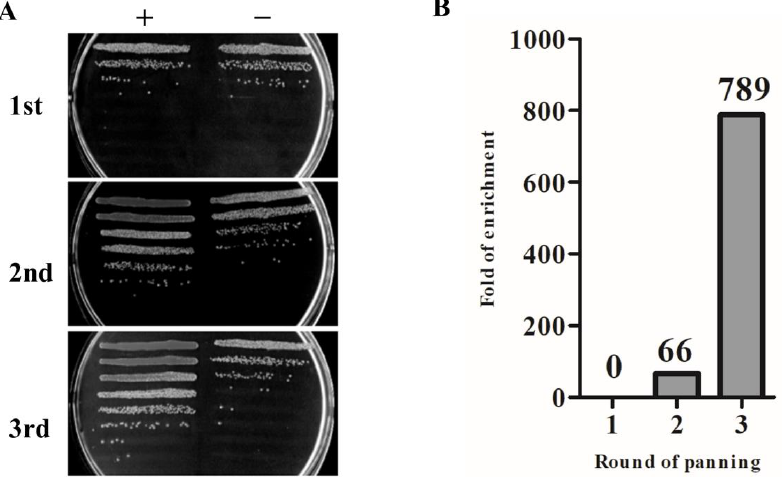
Figure 3. The enrichment effect of SARS-CoV-2 S-RBD phage display nanobody library after affinity screening. ( A ) The enrichment result was displayed for three rounds of panning. ( B ) The statistical result for enrichment fold. +: positive screened phage; −: negative screened